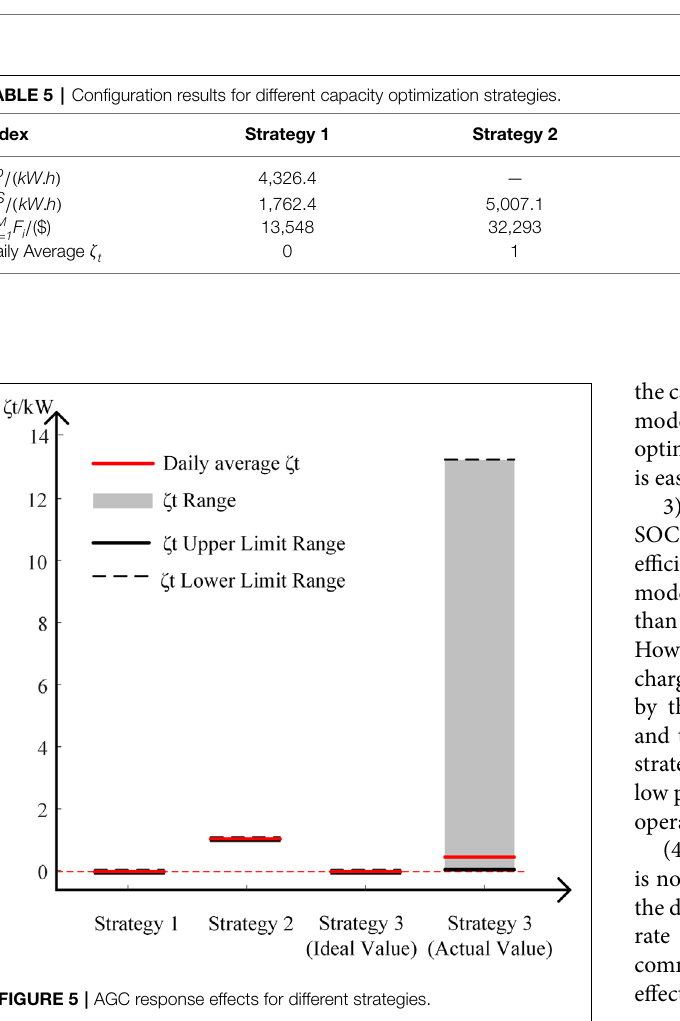
FIGURE 5 | AGC response effects for different